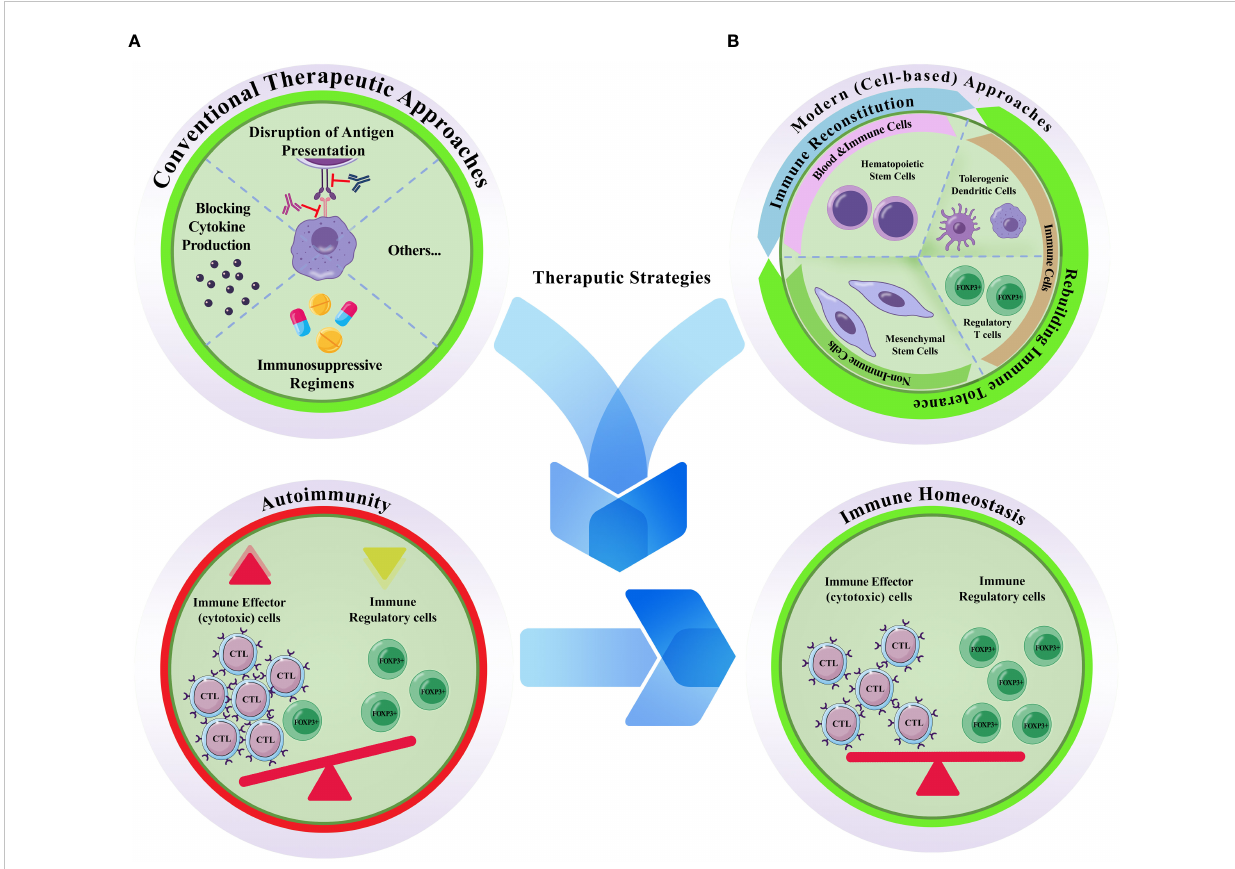
FIGURE 1 Conventional vs. modern cell based therapeutic approaches for autoimmune diseases. (A) Conventional therapeutic approaches are mostly depend on disruption of antigen presentation, blocking cytokine production, and/or the prescription of immunosuppressive regimens. (B) Modern cell-based therapeutics. Hematopoietic stem cells, tolerogenic dendritic cells, regulatory T cells, and mesenchymal stem cells are the four main cellular sources that have been proposed to treat autoimmune diseases. Autoimmunity is accompanied by abnormal accumulation of activated immune effector cells (mostly cytotoxic T lymphocytes; CTLs) and concurrent decrease/functional de fi ciency of the inhibitory/regulatory cells (FOXP3+) of the immune system; otherwise it is de fi ned as the failure of the self-tolerance. Hence, effective therapeutic strategies are those with the capacity to re- induce the homeostatic state of the immune system. While hematopoietic stem cell transplantation can reconstitute the immune system, the effects of the other three cell types are attributed to their capacity for rebuilding autoimmune tolerance. Unlike the conventional methods which are typically temporary, and are accompanied by harsh side effects, cellular toxicity, and single-effect mechanism of action, cell-based methods are provide the patients with a long-lasting alleviative